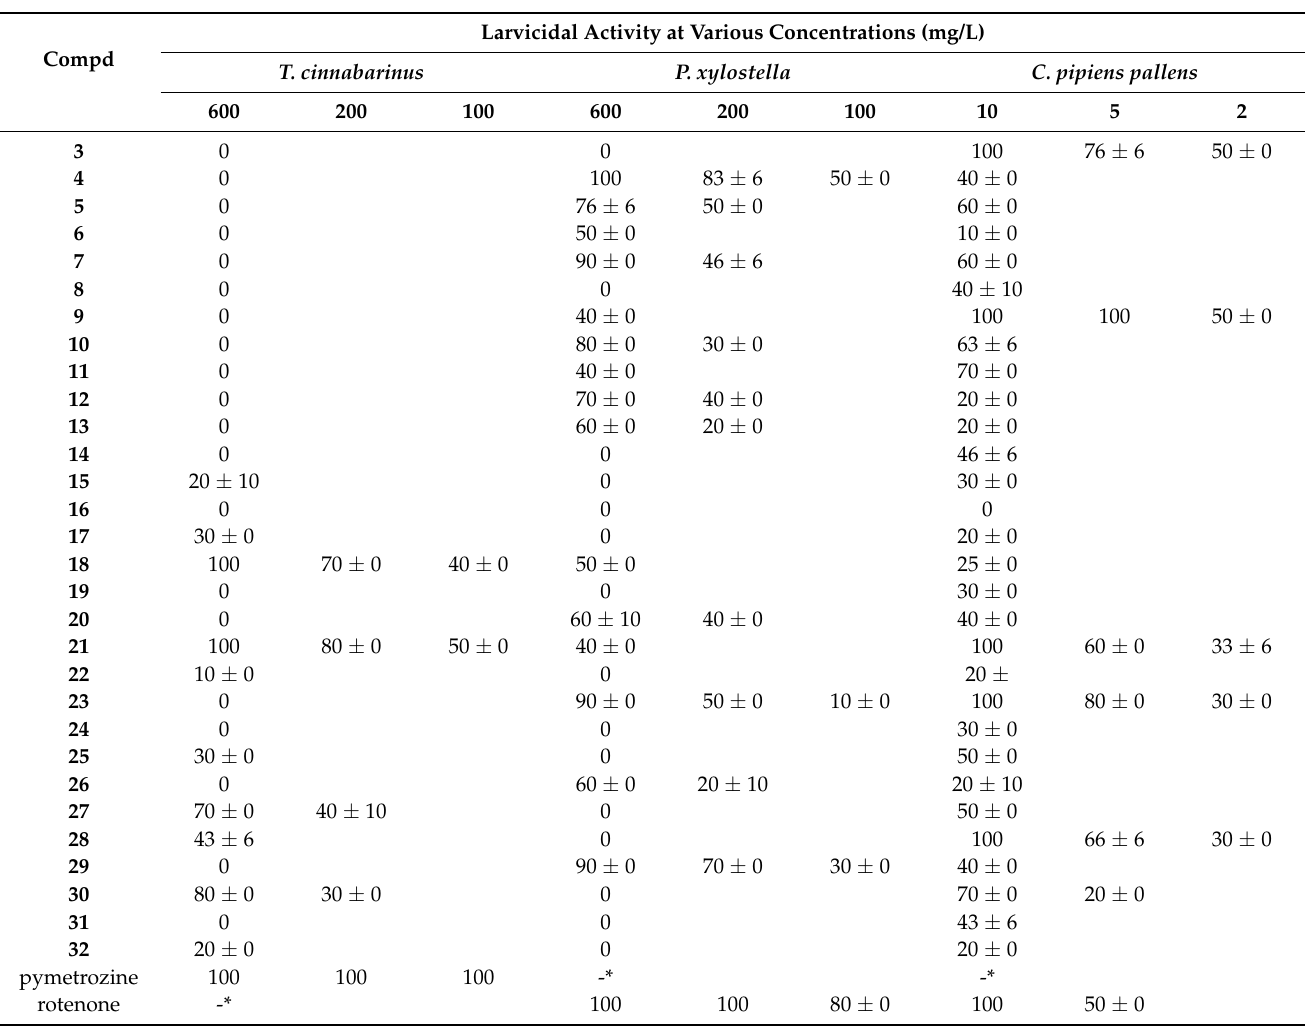
Table 4. Larvicidal activities of compounds 3 – 32 against T. cinnabarinus , P. xylostella , and C. pipiens pallens